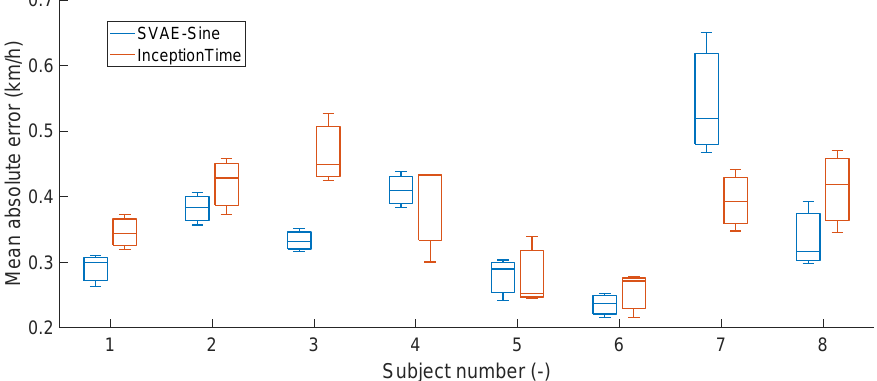
Figure 6. Boxplot of prediction error for all subjects in the study for the best performing SVAE-Sine architecture and the best feed-forward method, InceptionTime.